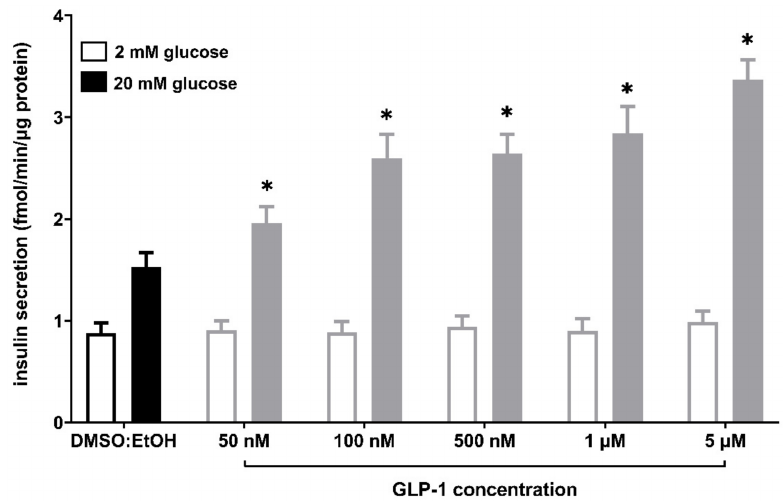
Figure 6. GSIS in MIN6 cells stimulated with GLP-1 in 50 nM, 100 nM, 500 nM, 1 µ M, and 5 µ M concentrations versus compound solvent control (DMSO:EtOH). Results are presented as means ± SEM from 3-4 independent experiments, 4-5 biological replicates each. Secreted insulin was quantified at 2 mM glucose (open bars) and 20 mM glucose conditions (closed bars). p < 0.05 for secretion was significantly different from 20 mM glucose control (*). No statistically significant difference was observed between control conditions and GLP-1-stimulated samples at 2 mM glucose.